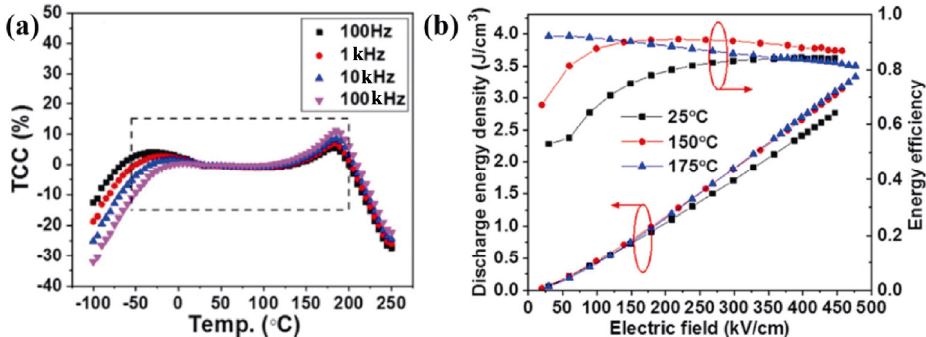
Fig. 28 (a) Temperature coefficient of capacitance (TCC) and (b) from Ref. [132], © The American Ceramic Society